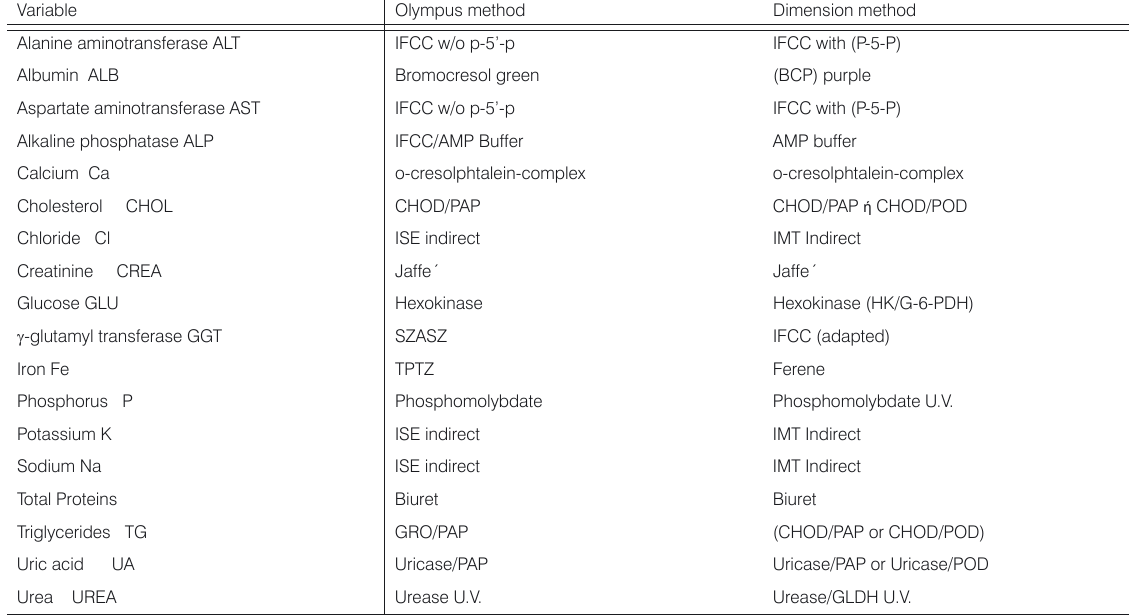
Table 1. Methods used for the determination of the different quantities (37 o